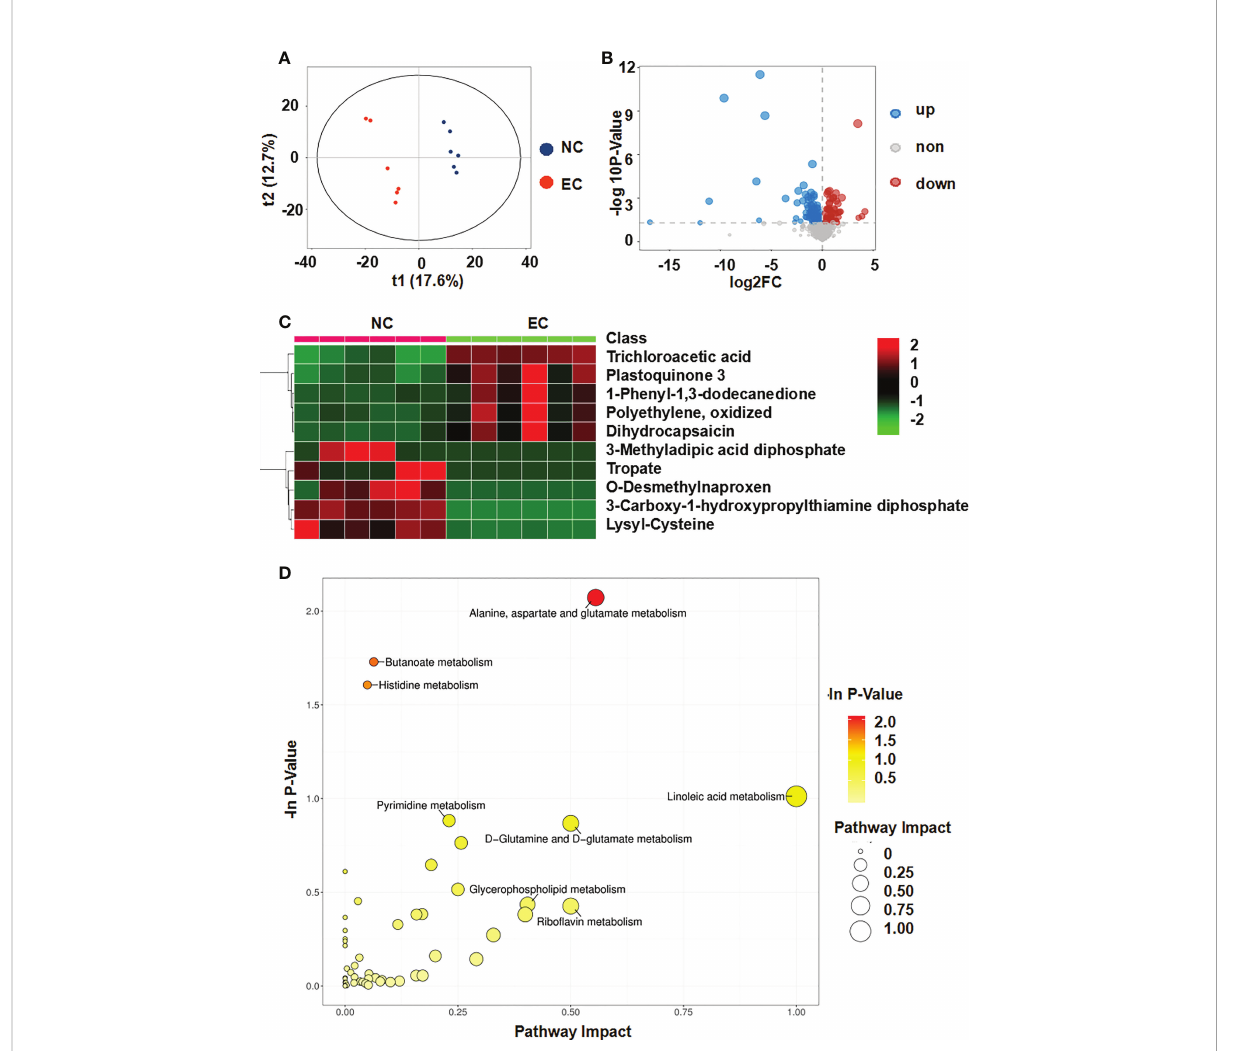
FIGURE 4 Metabolomic analysis of the serum of rats after administering ethanol. (A) Score plots of the orthogonal projections to latent structure- discriminant analysis (OPLS-DA) model between NC and EC groups. (B) Volcano plot of differential metabolites. (C) Community heatmap of the differential metabolites. (D) Bubble plots of pathway analysis between NC and EC